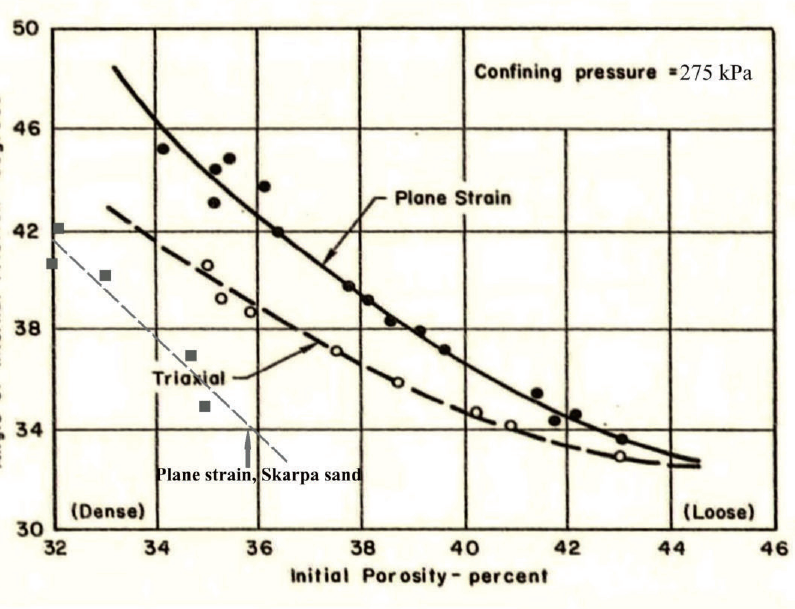
Figure 3: Comparison of the results from drained triaxial and plane strain tests on sand [18] and true-triaxial tests on Skarpa